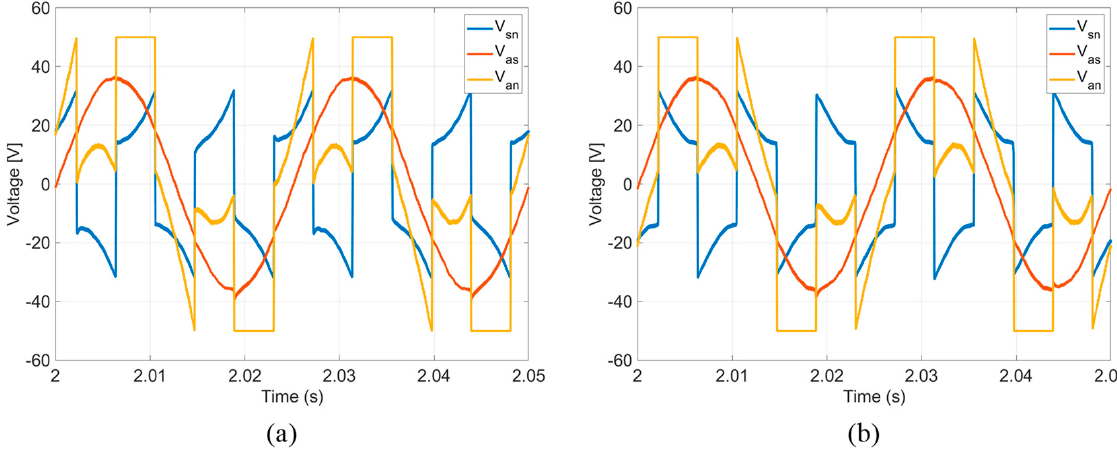
Figure 9. Voltage relationships of the 60° DPWM: ( a ) 60° (+30°) DPWM;( b ) 60° ( − 30°) DPWM.